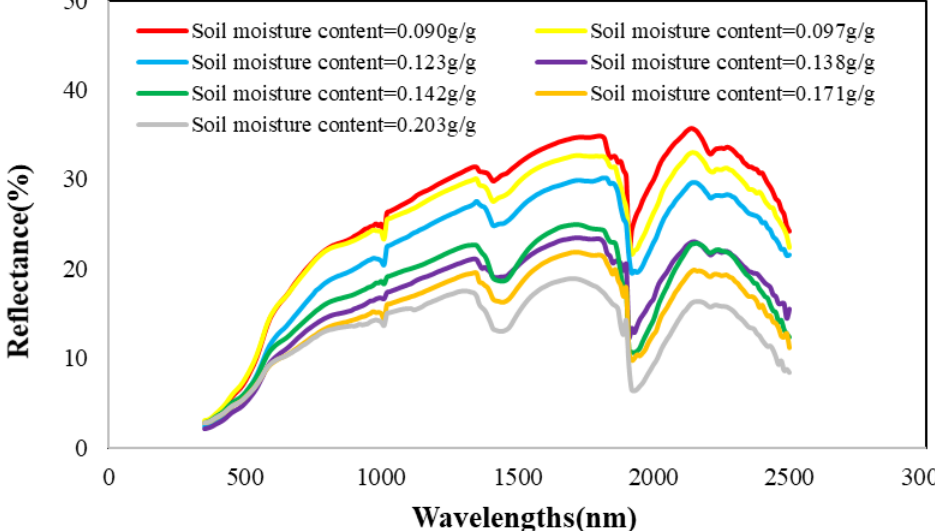
Figure 4. The soil reflectance with various soil-moisture contents.